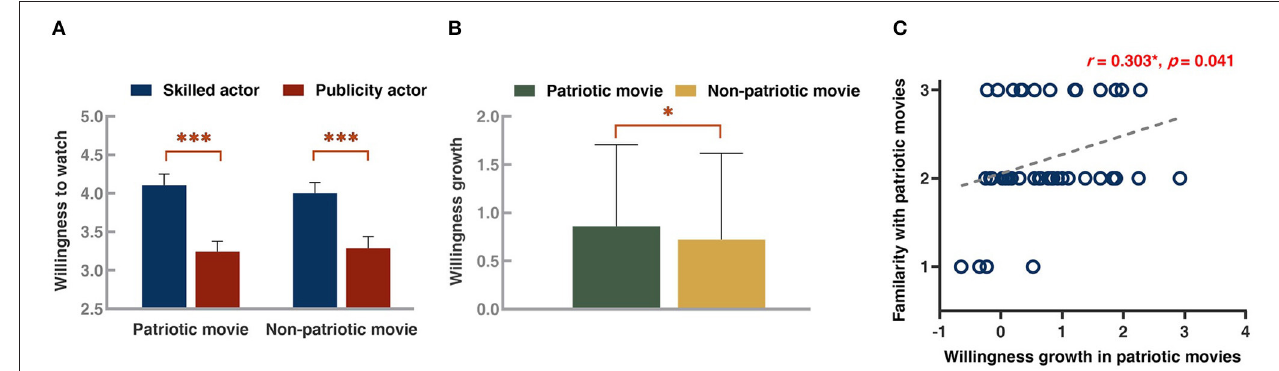
FIGURE 2 | Behavioral results. (A) Average willingness under four conditions. (B) Willingness differences (skilled–publicity) in two movie types. (C) Scatter plots of Pearson’s correlation coefficient analysis results between the familiarity level with patriotic movies and the willingness growth in such movies. The willingness growth represented the willingness difference (skilled–publicity) in each movie type. Blue, red, green, and yellow in bar graphs stood for skilled, publicity, patriotic, and non-patriotic. Error bar: standard error, * p < 0.05, *** p <